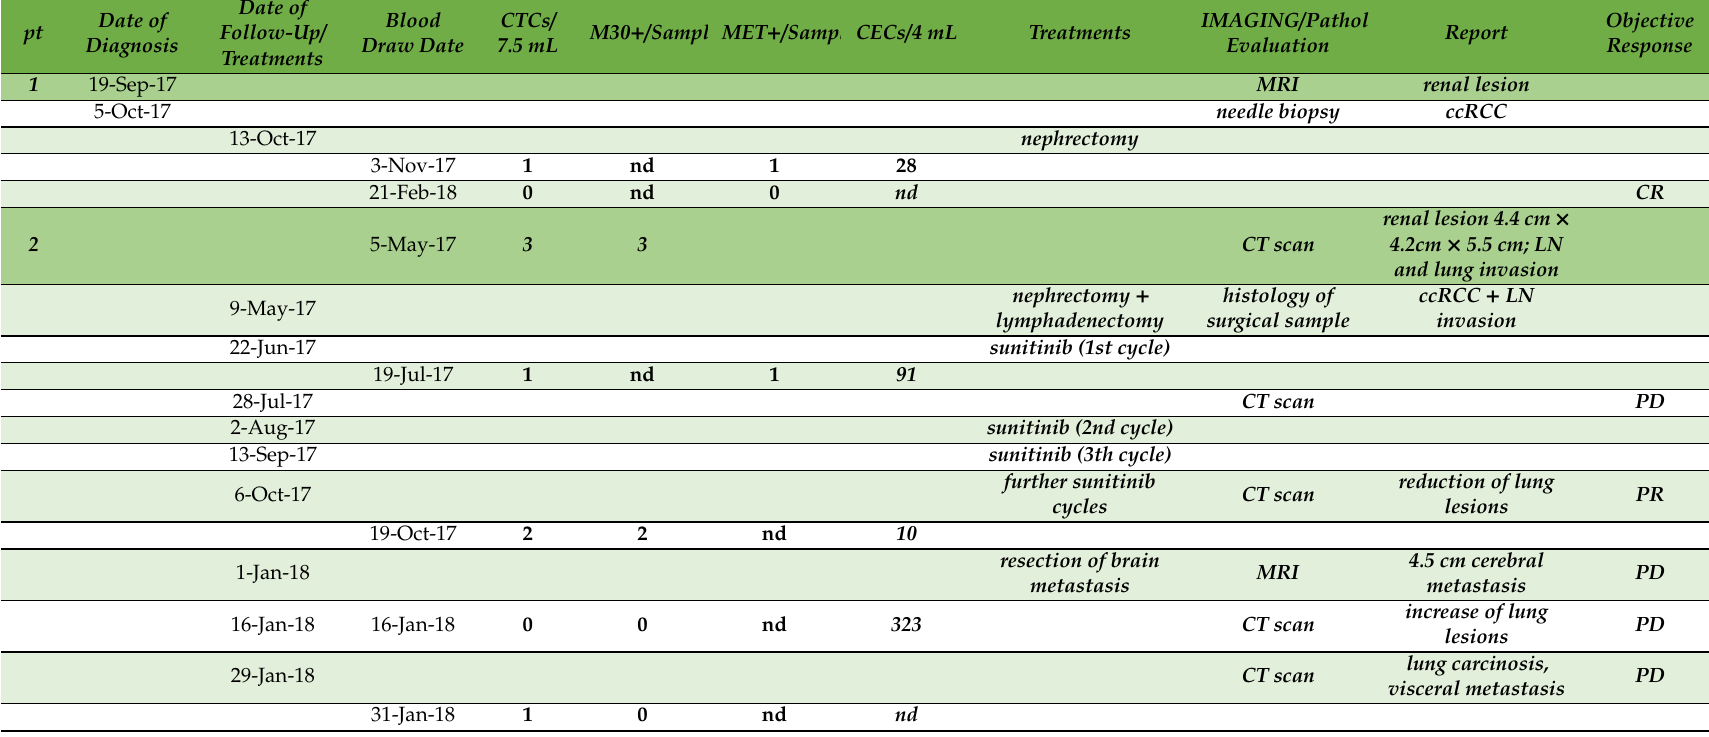
Table 1. Clinical diary of treatments, imaging and pathological evaluations, and liquid biopsy